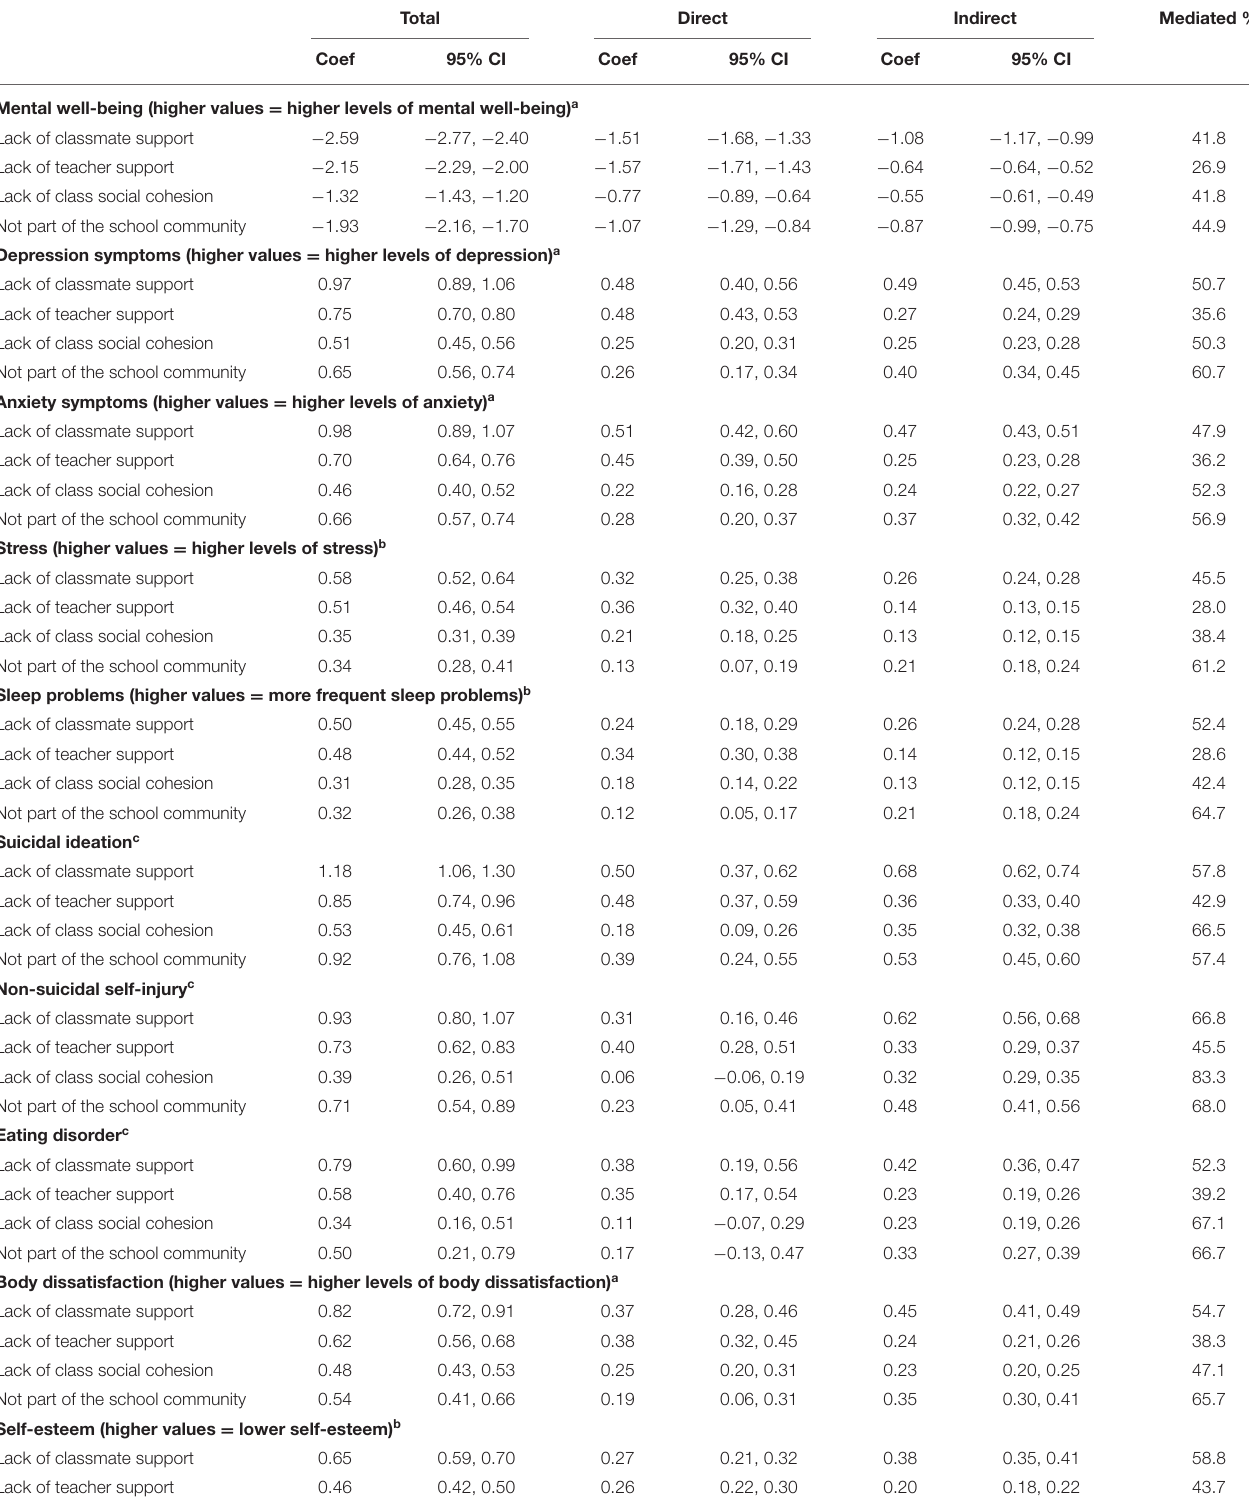
TABLE 2 | Regression analyses predicting mental health outcomes by types of social disconnectedness in school (each type in separate models) with loneliness as the mediating variable ( khb method). Total Direct Indirect Mediated % Coef 95% CI Coef 95% CI Coef 95%